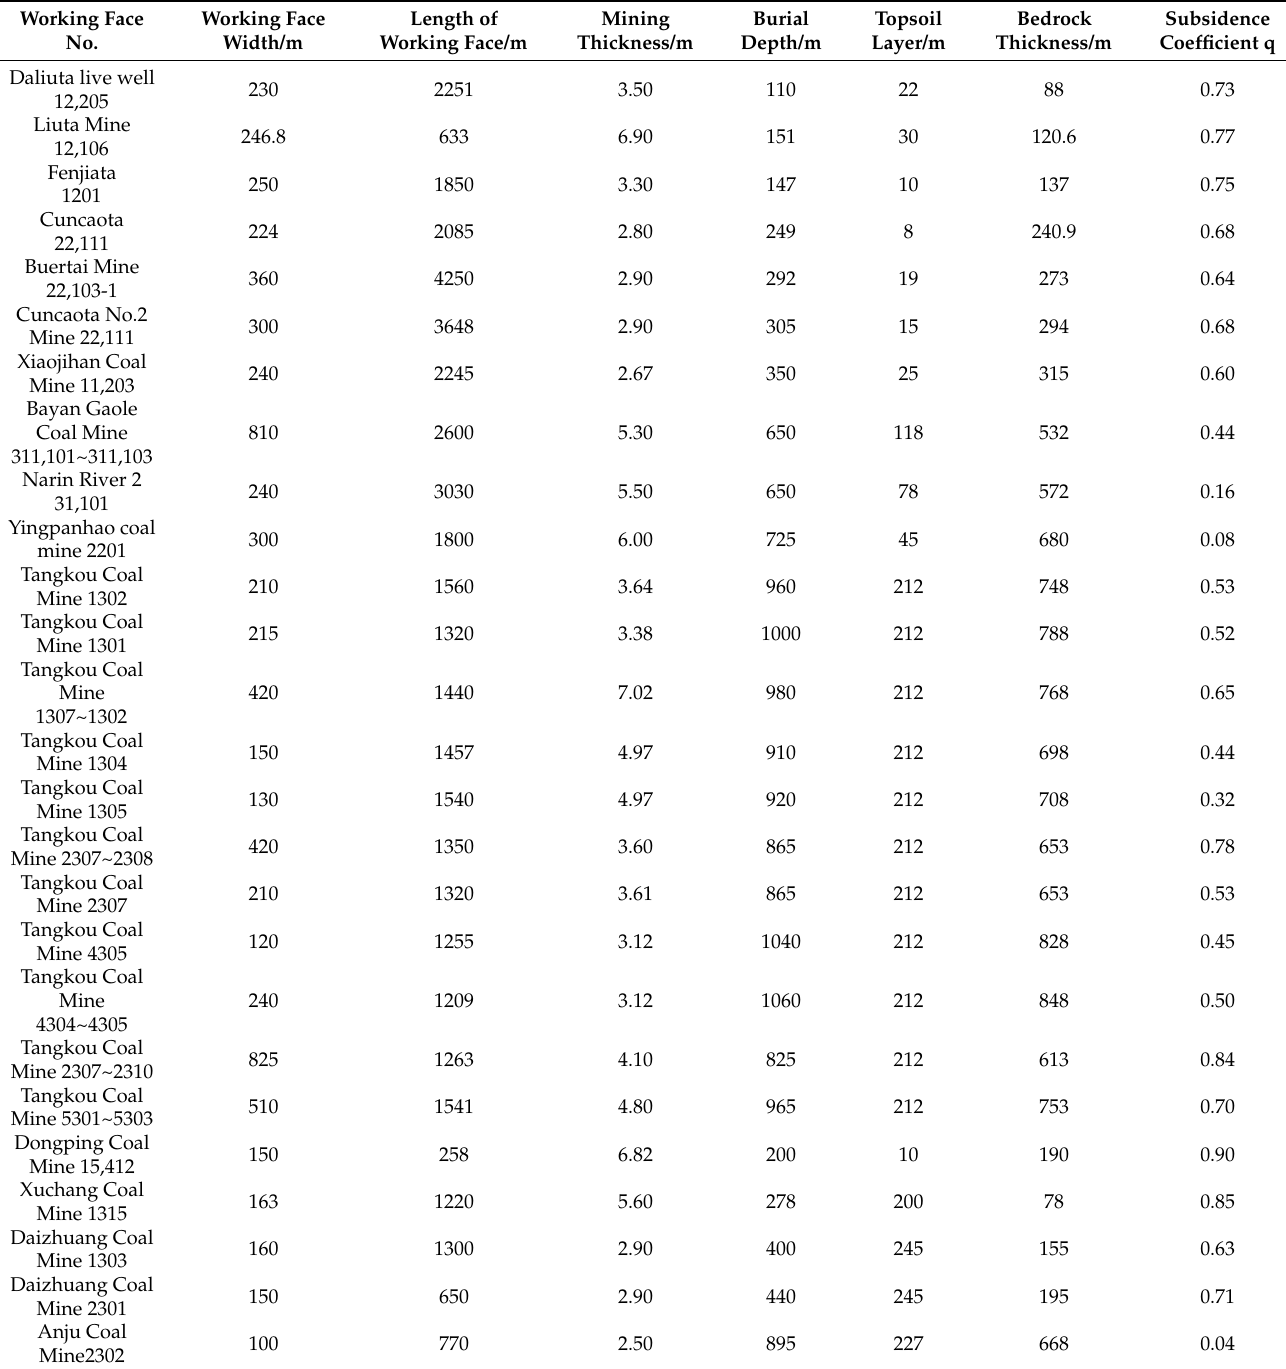
Table 2. Surface subsidence factors in the east and west mining